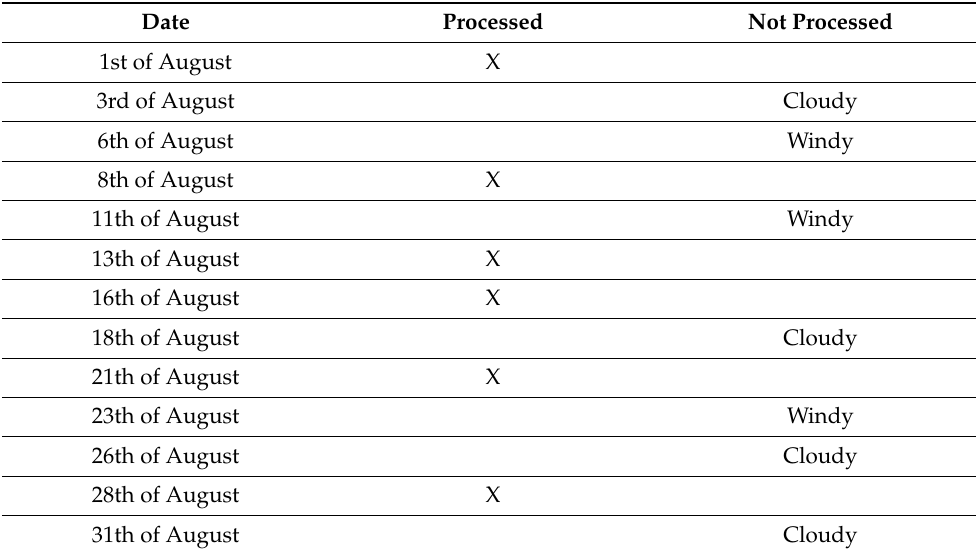
Figure 1. Mosaic of the Sentinel-2 scenes over North Adriatic (4 tiles on 13th of August 2020, ‘true colour’ RGB combination) with the indication of main rivers (white) and lagoons (yellow). Table 1. Sentinel-2 scenes acquired in August 2020 in North